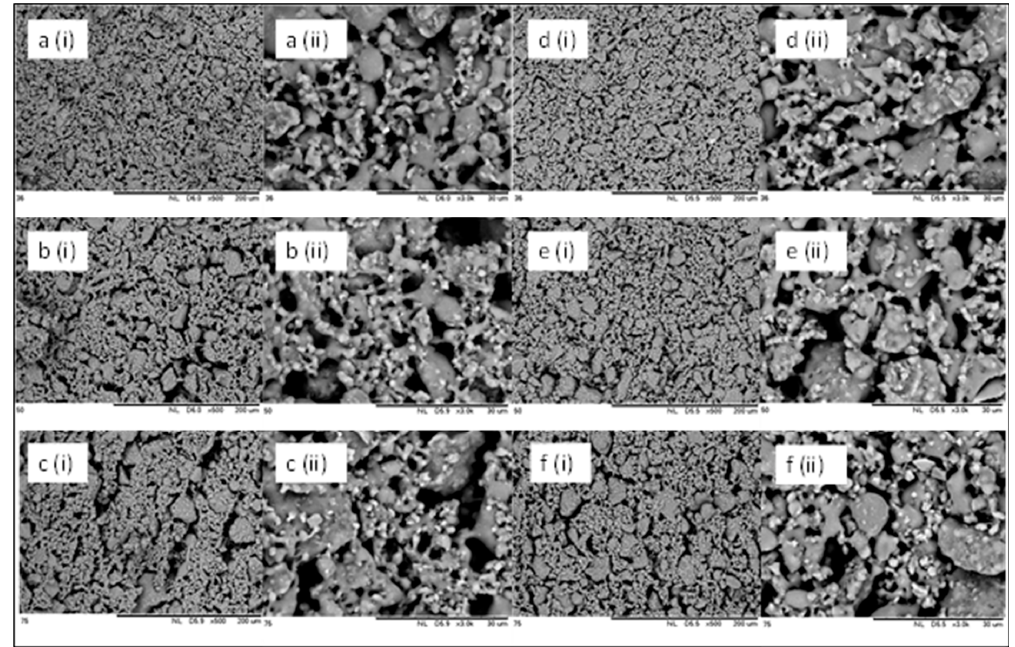
Figure 4. SEM micrographs of the HFCMs of inner surface of ( a ) 36 μ m, ( b ) 50 μ m, and ( c ) 75 μ m, and outer surface of ( d ) 36 μ m, ( e ) 50 μ m, and ( f ) 75 μ m at different magnifications of ( i ) ×60 and ( ii ) ×500.